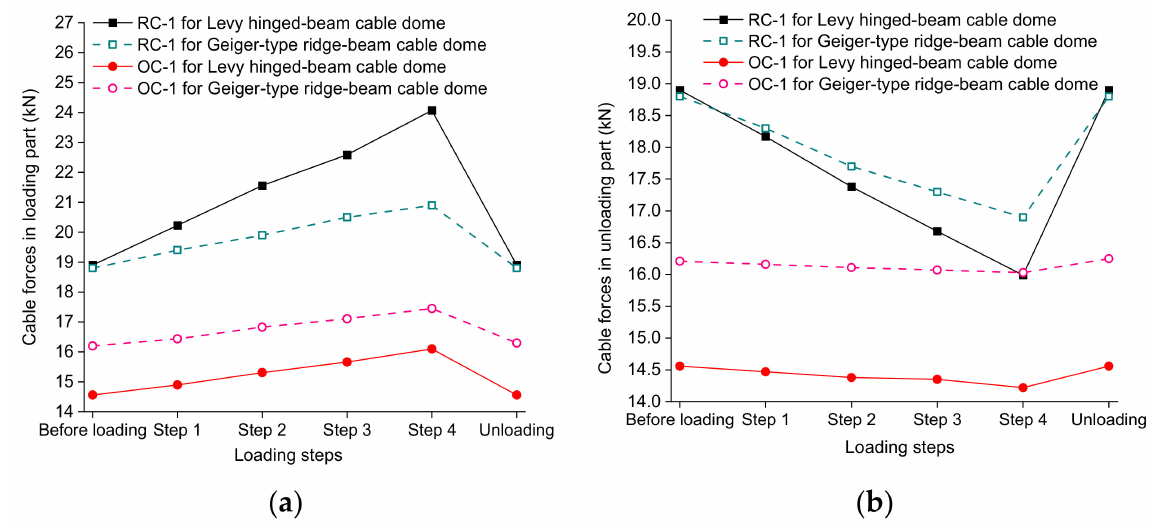
Figure 35. Comparative results of the cable forces. ( a ) Loading part; ( b ) Unloading